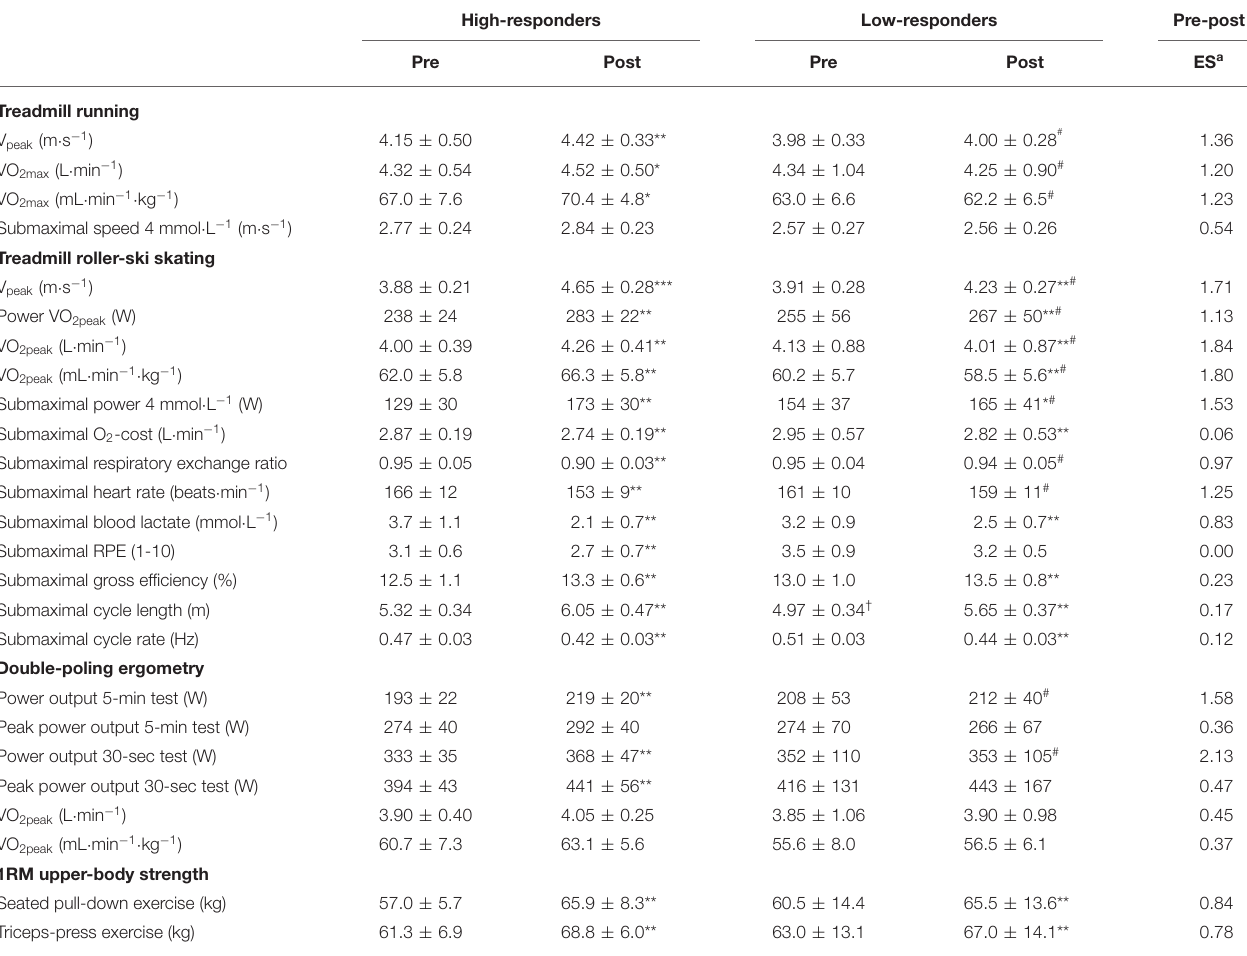
TABLE 1 | Performance, physiological and technical capacities (mean ± SD) in treadmill running, treadmill roller-ski skating and double-poling ergometry as well as upper-body 1RM strength in high and low-responders at pre and post of a 6-month XC ski-specific training period.